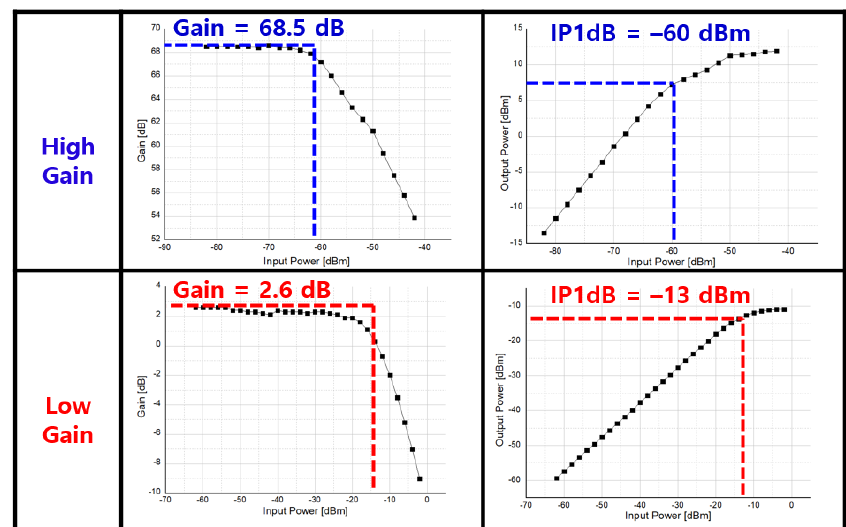
Figure 36. Receiver RF Front-End P1dB measurement result.